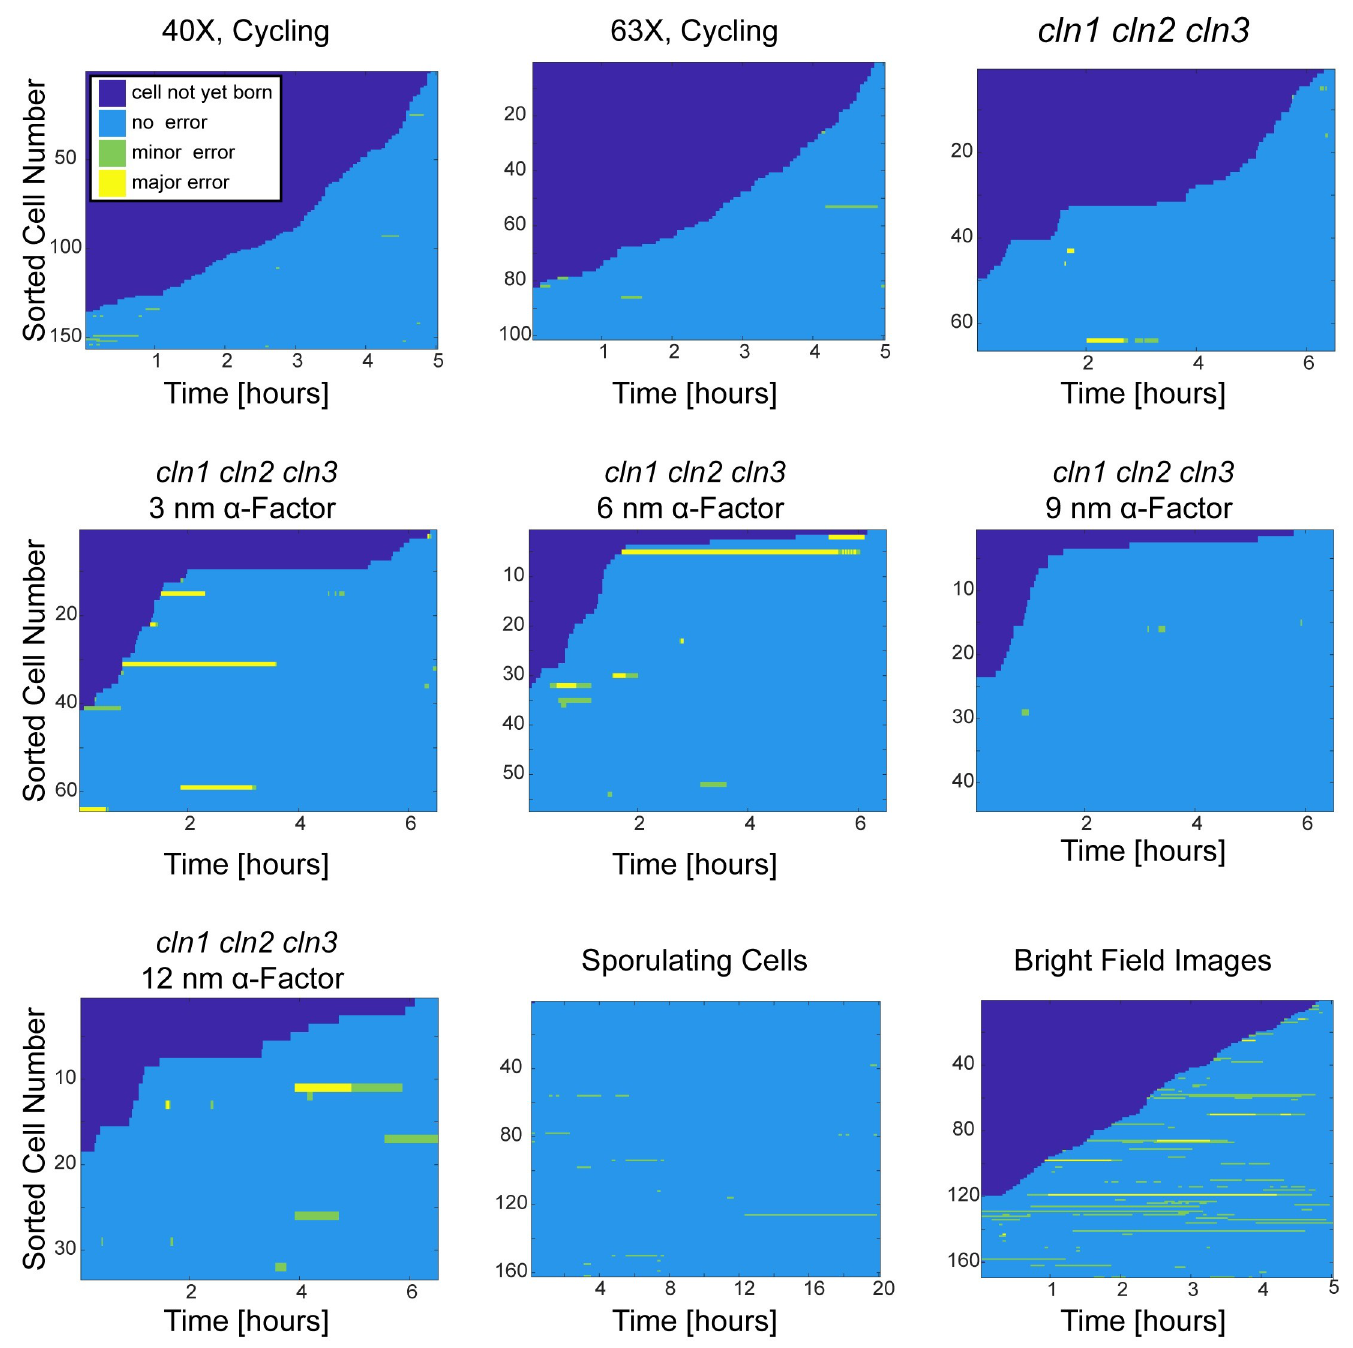
Fig 10. Overall performance of segmentation examples. Sorted cell traces for every example case. Time points where the cell is not yet born are dark blue. Correct segmentations are labeled blue, minor errors green and major segmentation errors yellow. The errors were scored manually. For quantification see Table 7.